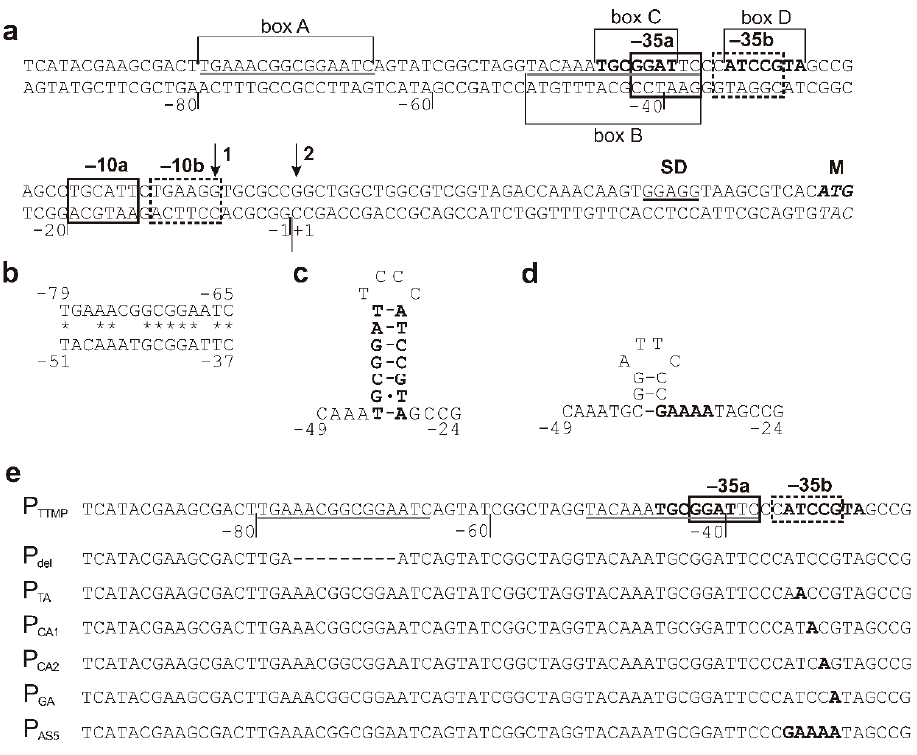
Figure 4. ( a ) P TTMP core promoter elements. Arrows indicate transcription start sites, the − 10 and − 35 regions are boxed (the elements of the first promoter are indicated by solid-line boxes and the elements of the second promoter are indicated by dotted-line boxes), and the nucleotides that potentially form the secondary structures are given in bold; nucleotide sequence repeats are underlined by a grey line; Shine–Dalgarno sequence is underlined by a black line; the first translation codon is marked. ( b ) The comparison of 15 nt direct repeats. ( c ) The predicted secondary structure formed by the 7 nt inverted sequences. ( d ) A new secondary structure formed after the mutation of the promoter sequence (changed nucleotides are given in bold). ( e ) The mutations of P TTMP . The top line represents the wild-type promoter sequence. The dash indicates the deleted nucleotide; the substituted nucleotides are given in bold. Boxed regions correspond to the − 35 promoter elements; nucleotides that potentially form the secondary structures are given in bold; and the nucleotide sequence repeats are underlined by a grey line.